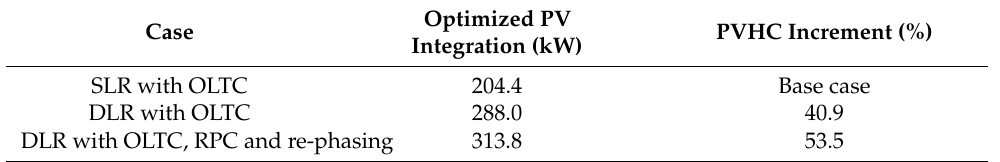
Table 2. Summary of the